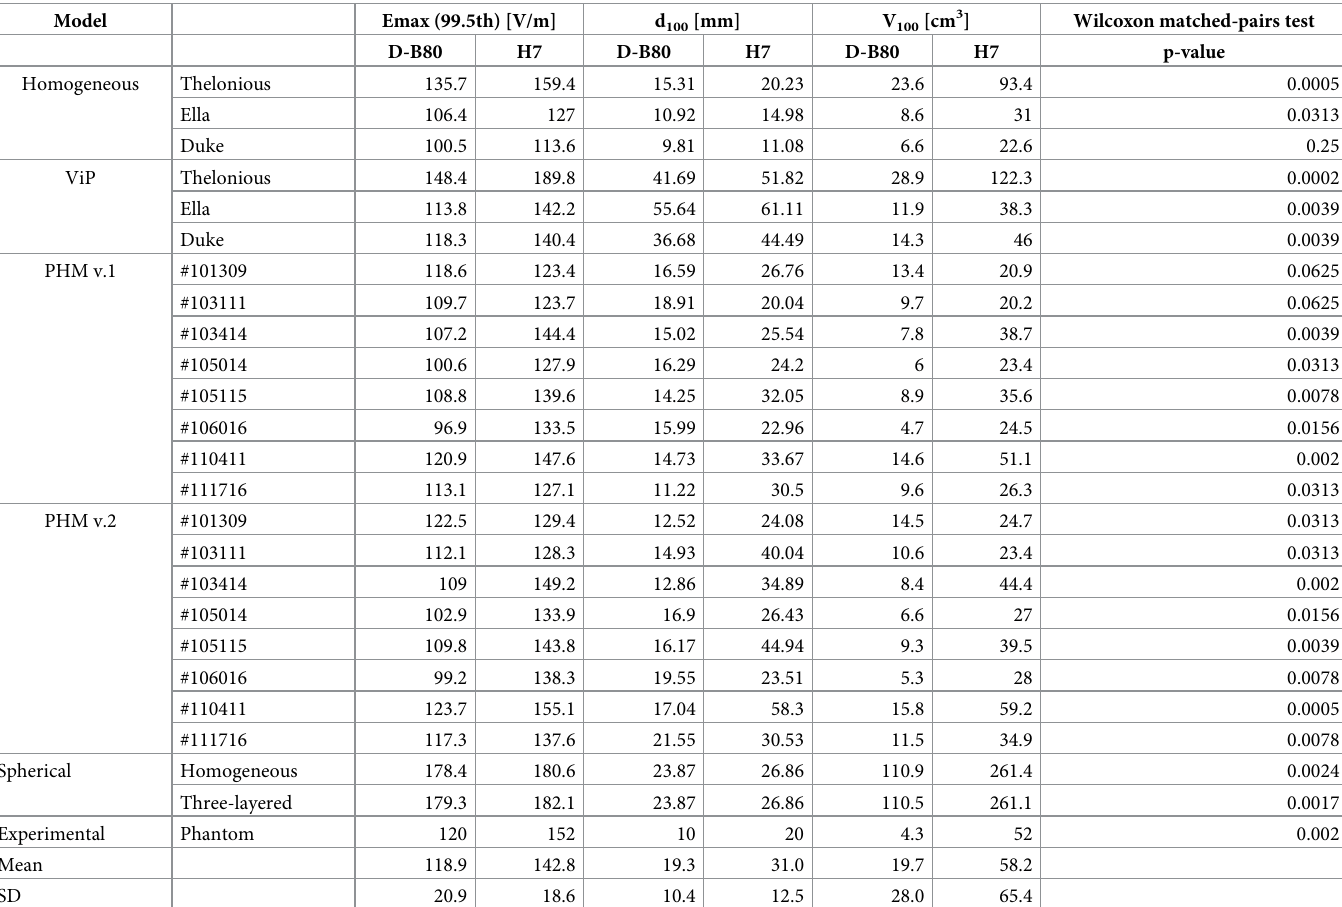
Table 1. Stimulation volumes V 100 (cm 3 ), stimulated depth d 100 (mm) and maximal electric field values E max (V/m) in the brain for simulations in 22 head models, 2 spherical models and for phantom measurements. Shown are results of comparison of stimulation volumes V 100 in the brain between the D–B80 and H7 coils using Wilcoxon matched–pairs